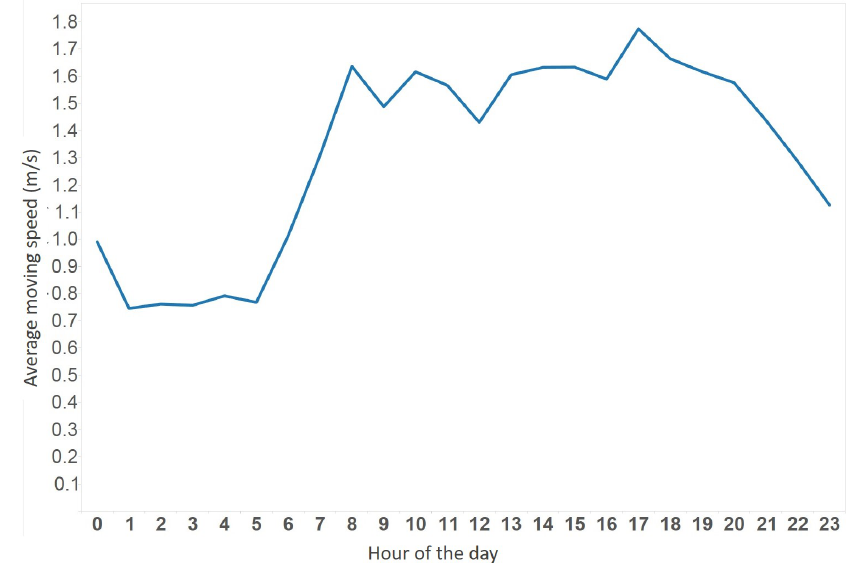
Figure 12. The average speed of all tagged carts in different